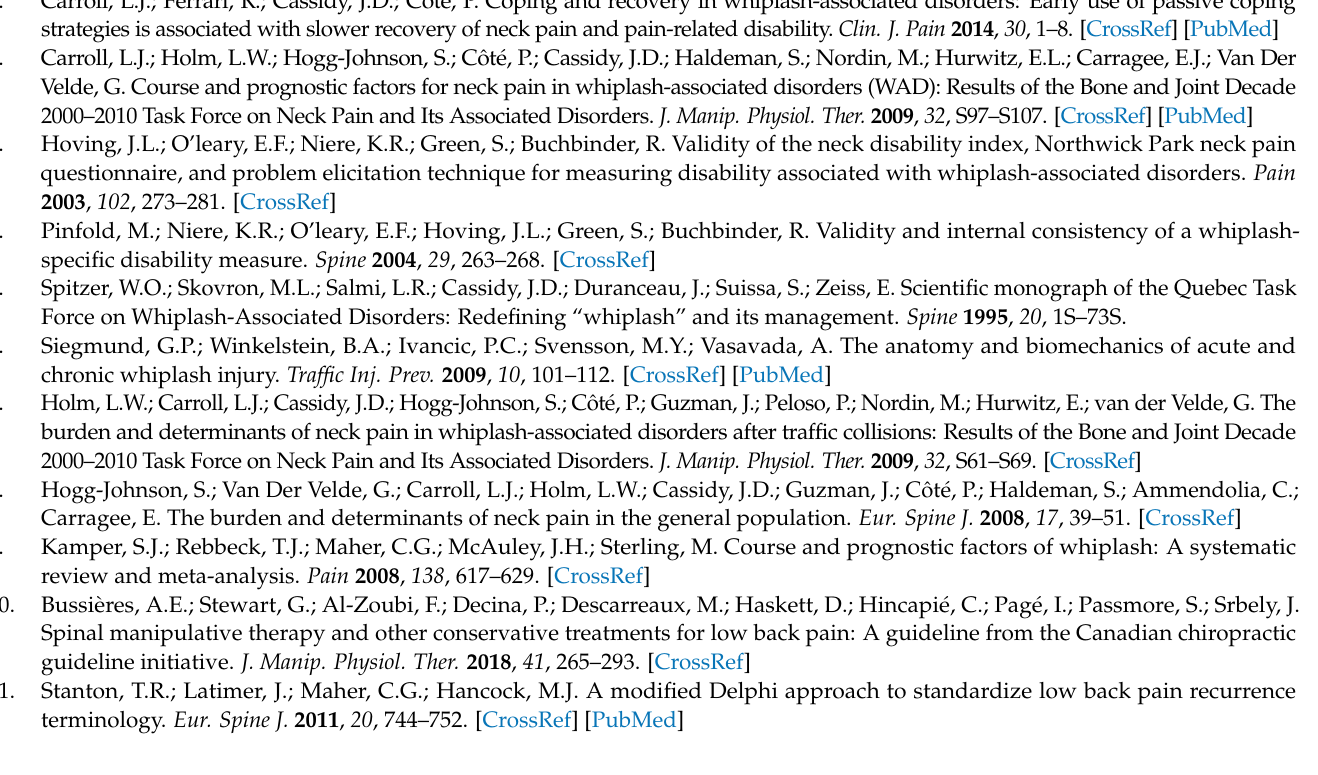
groups are presented; Figure S4: Boxplots of mean velocity of all three groups. Results of Post hoc tests between groups are presented; Figure S5: Boxplots of smoothness of movement of all three groups. Results of Post hoc tests between groups are presented; Figure S6: Boxplots of normalized EMG recorded from SCM during submaximal craniocervical flexion task. Results of Post hoc tests between groups are presented; Figure S7: Maximal neck strength in flexion (A) and extension (B). Borg’s scale was used to measure perceived fatigue during submaximal contraction at 20% MVC; Figure S8: line plot showing mean number of days with pain (outcome) over 12 months follow- up period; Figure S9: Results of the Least absolute shrinkage and selection operator involving all predictors with Neck Disability Index as an outcome at 6 months; Figure S10: Results of the Least absolute shrinkage and selection operator involving all predictors with days with pain over the 12-month follow-up period as an outcome. Table S1: STROBE Statement—Checklist of items that should be included in reports of cross-sectional